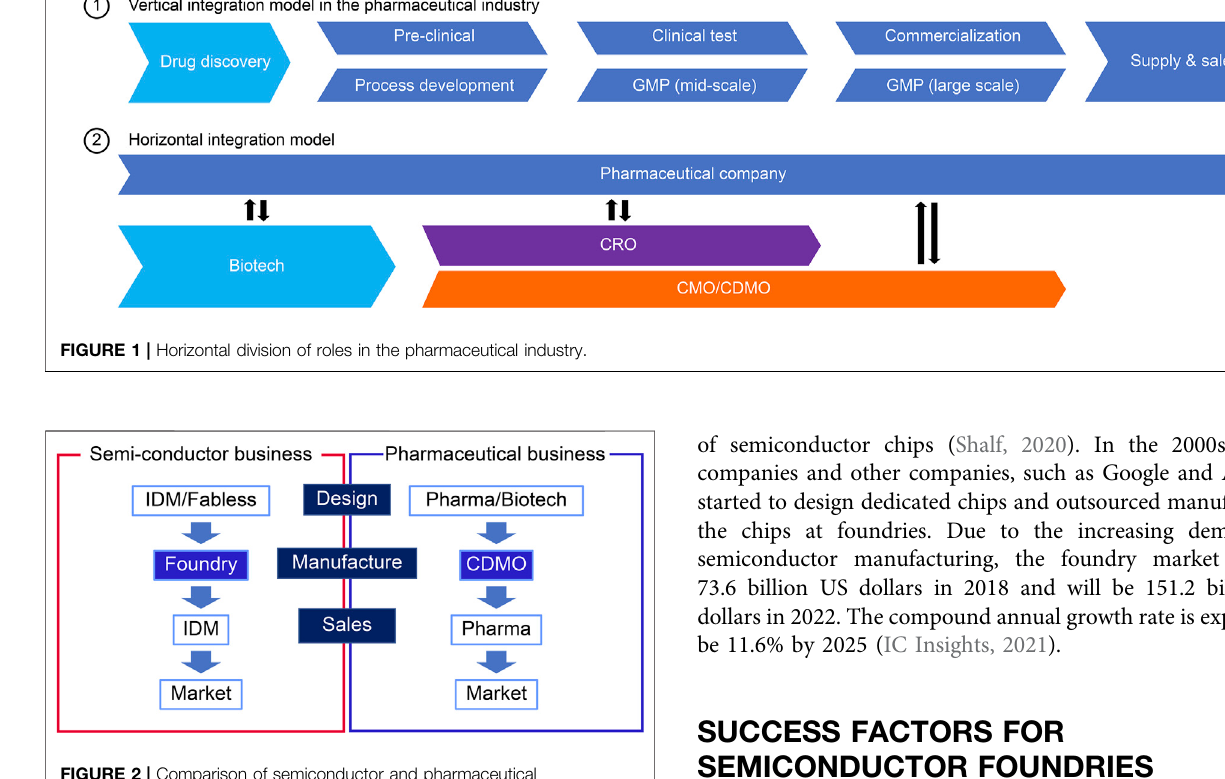
FIGURE 2 | Comparison of semiconductor and pharmaceutical